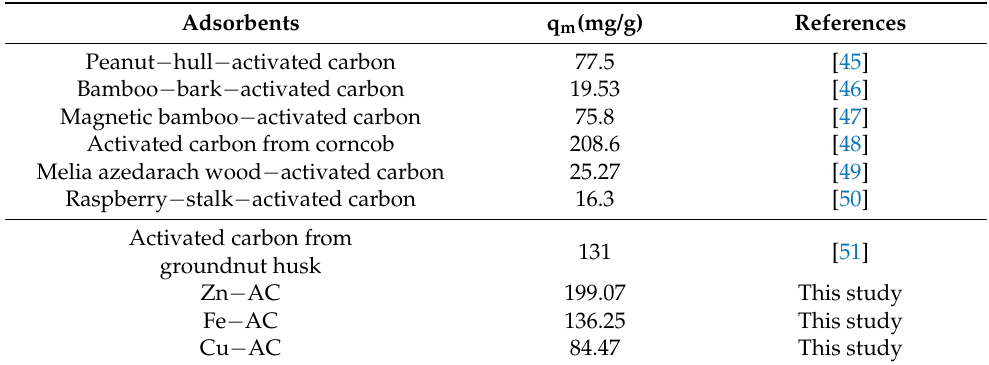
Table 3. Comparison of the maximum adsorption capacities of different adsorbents for Cr(VI). Adsorbents